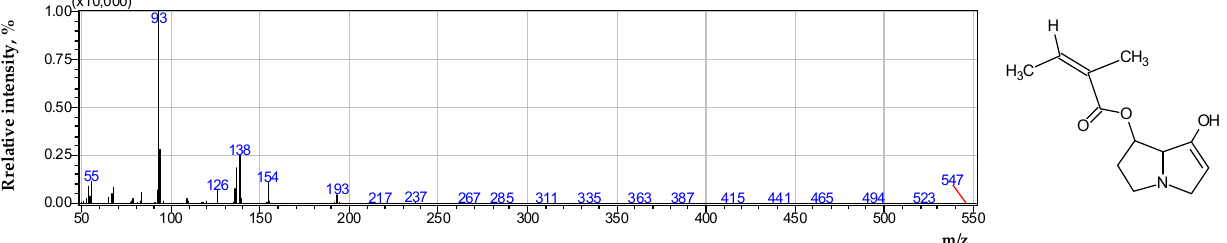
Figure 5. Mass spectrum at the top of the chromatographic peak 5.58 min, corresponding to 9-angeloylretronecin extracted from Symphytum officinale (reference mass ions [M + H] + m/z 138 and m/z 126).